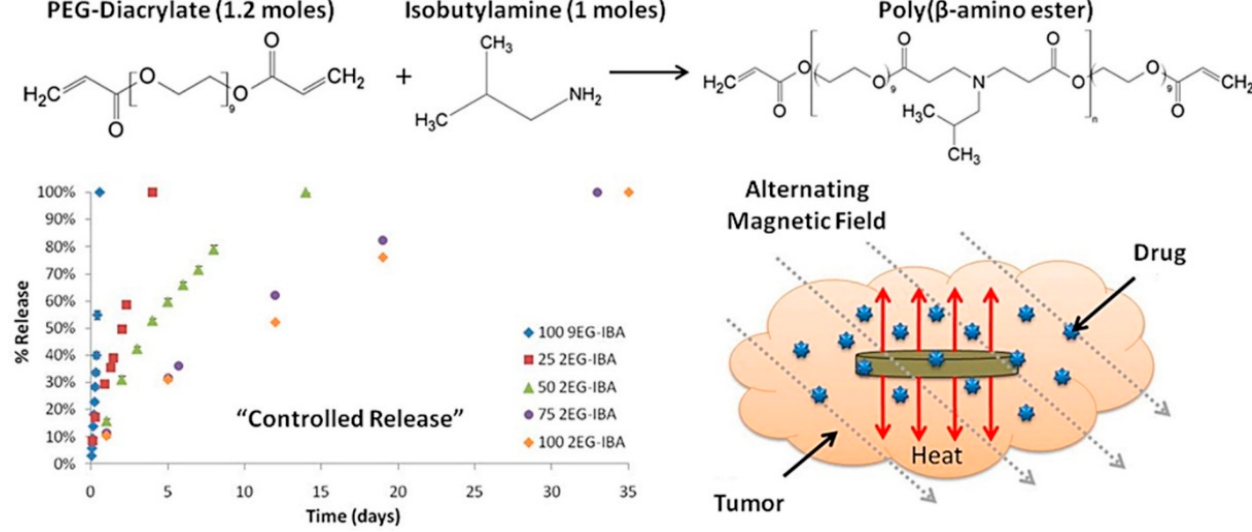
Figure 7. Synthesis of magnetic hydrogel for hyperthermia cancer treatment and controlled drug release [130] © 2021 Elsevier.